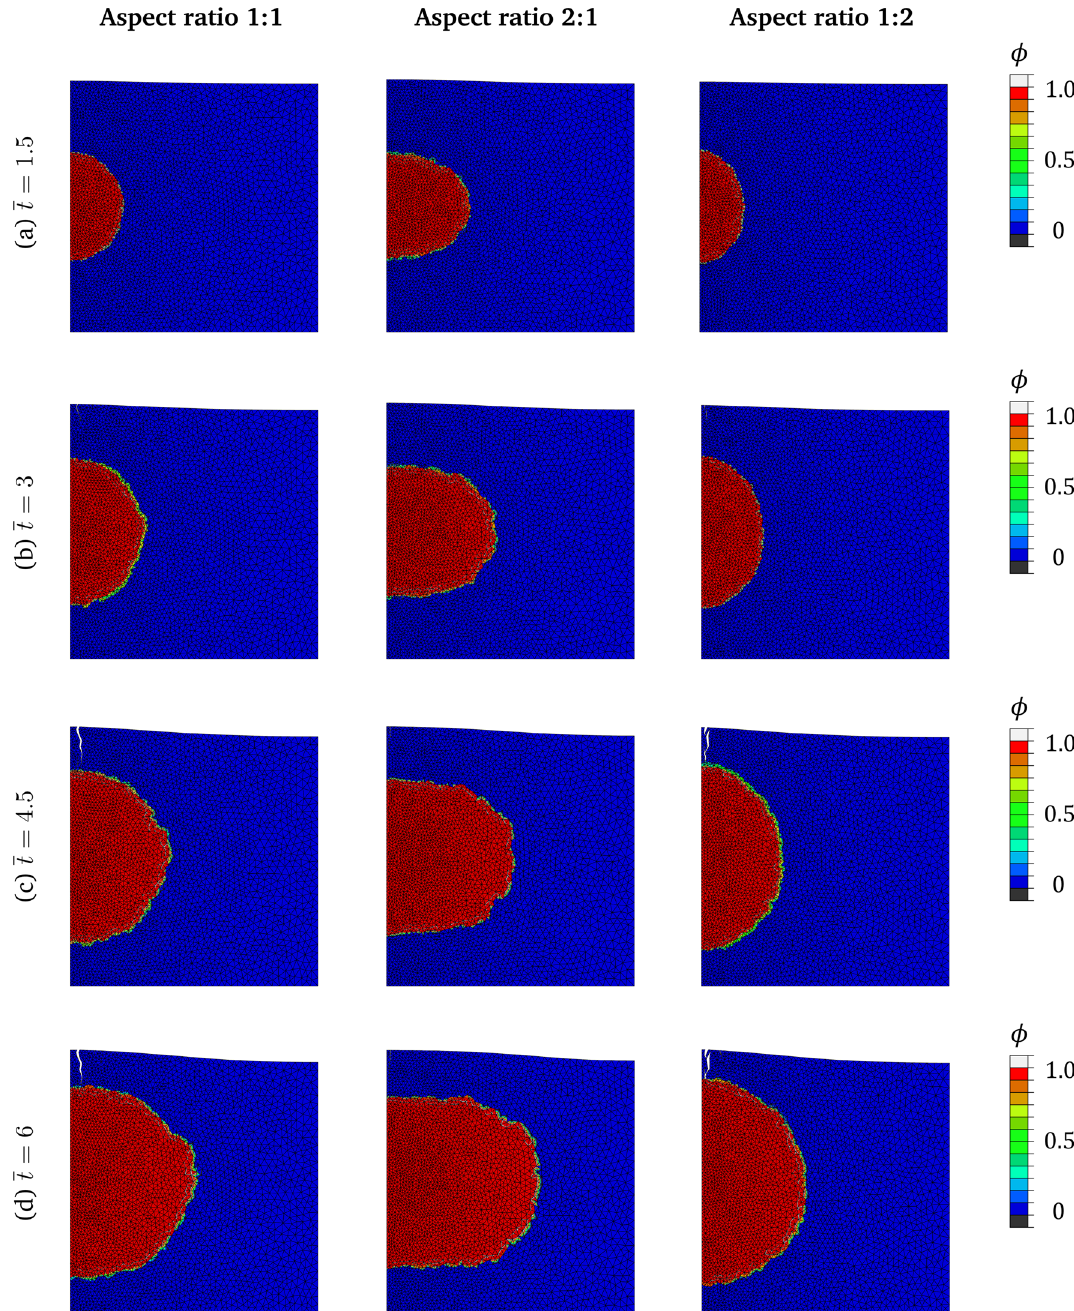
Fig. 4 Time evolution of the paint configuration (with the deforma- tion plotted at true scale) illustrating the growth of the metal soap crystal and the fracture and surface deflection of the paint material. The contour plot variable 𝜙 refers to the volume fraction of crystal-